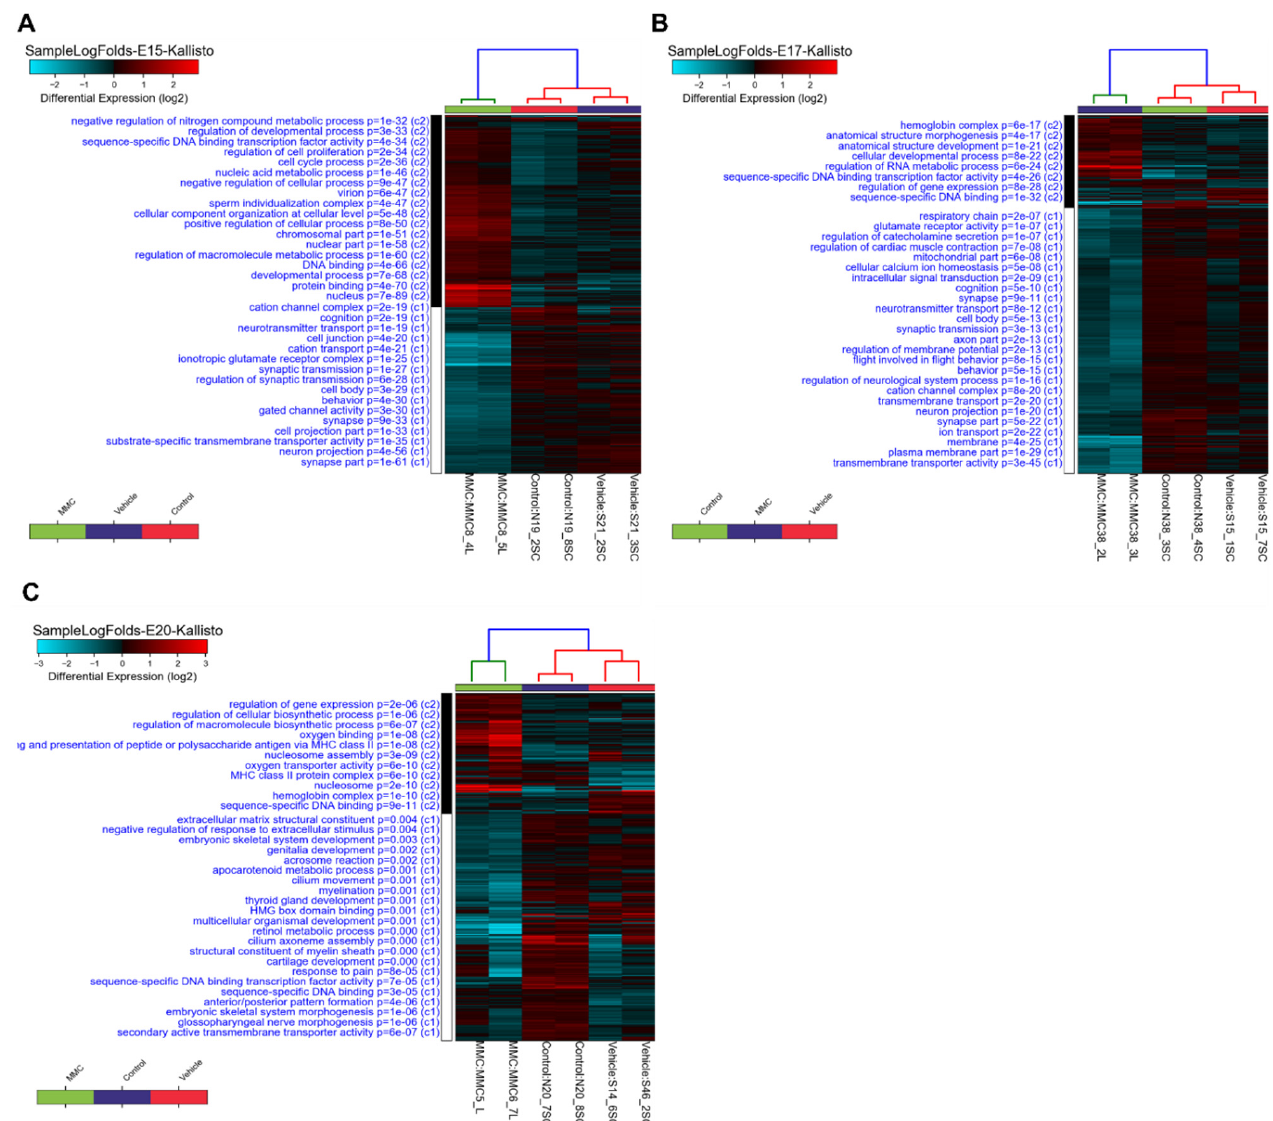
Figure 5. Hierarchical clustering analysis of differentially expressed genes in the spinal cord of MMC, vehicle, and control fetuses isolated at ( A ) E15, ( B ) E17, and ( C ) E20. Table 3. Top 25 upregulated and downregulated genes between MMC and vehicle groups at E15.